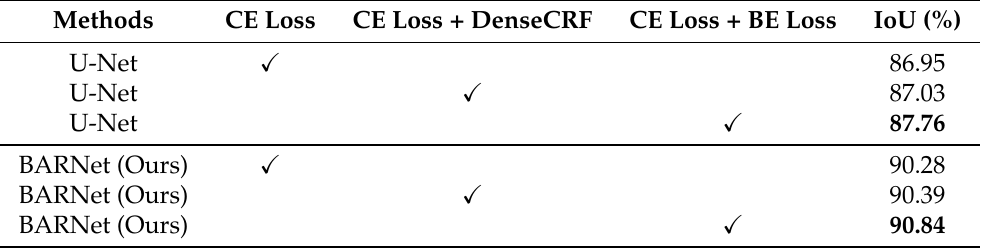
Table 5. Comparison of the Boundary-Enhanced (BE) loss and the Dense Conditional Random Field (DenseCRF), where the best is in bold. We report the results performed on the WHU dataset. (cid:88) means that the corresponding method is adopted. Note, OHEM and MS are not used for this